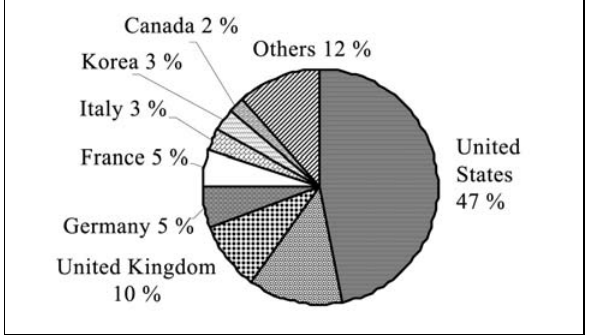
Fig 1. Total market share of the OECD countries in insurance business in